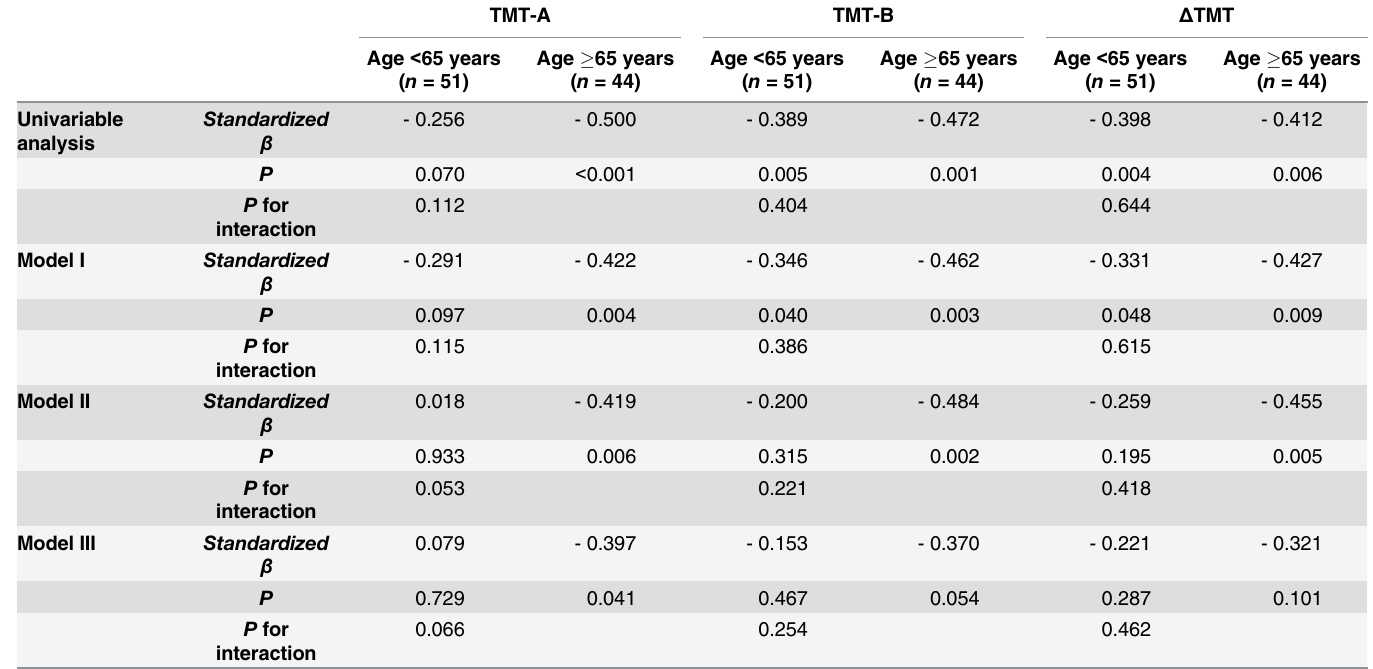
Table 5. Univariable and Multivariable-Adjusted Regression Analyses of Correlation between Normalized Whole-Brain GMV and TMT Scores in Participants Stratified by Age ( < 65 vs. (cid:3) 65 years). Model I: Multivariable analysis adjusted for sex and age. Model II: Model I + diabetes mellitus, esti- mated glomerular filtration rate, and education. Model III: Model II + systolic blood pressure, smoking habits, drinking habits, hemoglobin, previous history of cardiovascular disease, and log-transformed urinary protein to creatinine ratio. Abbreviation: GMV, gray matter volume; TMT, Trail Making